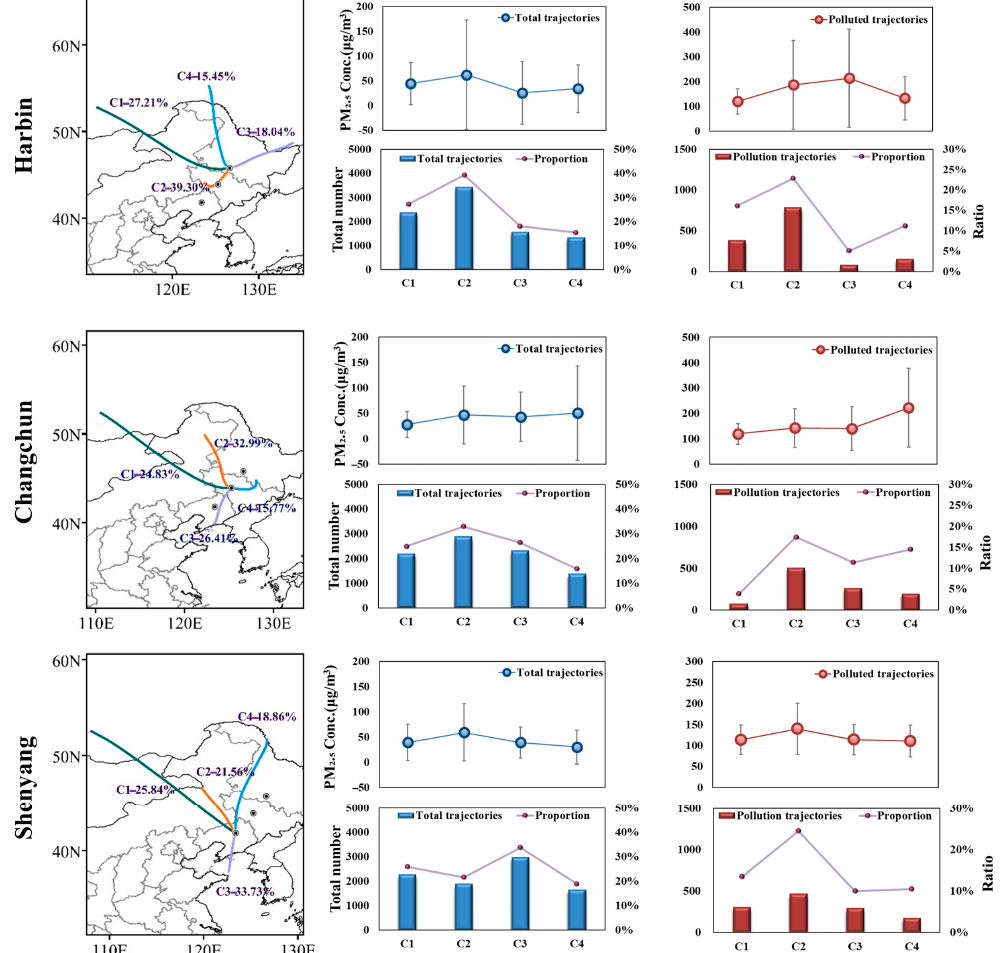
Figure 7. Backward trajectory analysis and statistical results of the total number of cleaning and pollution trajectories in Harbin, Changchun and Shenyang in 2020.